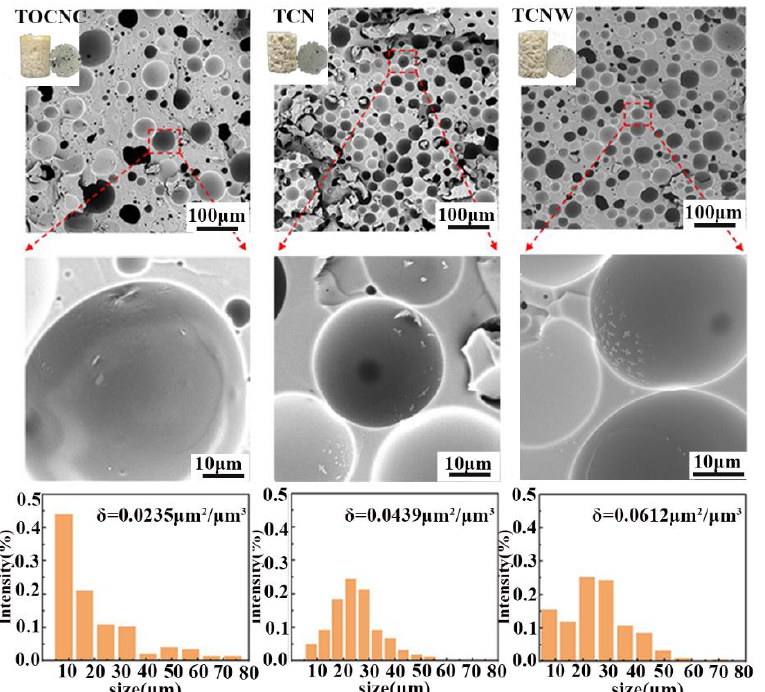
Figure 7. SEM images, specific surface of unit volumes and pore size distributions of foams.